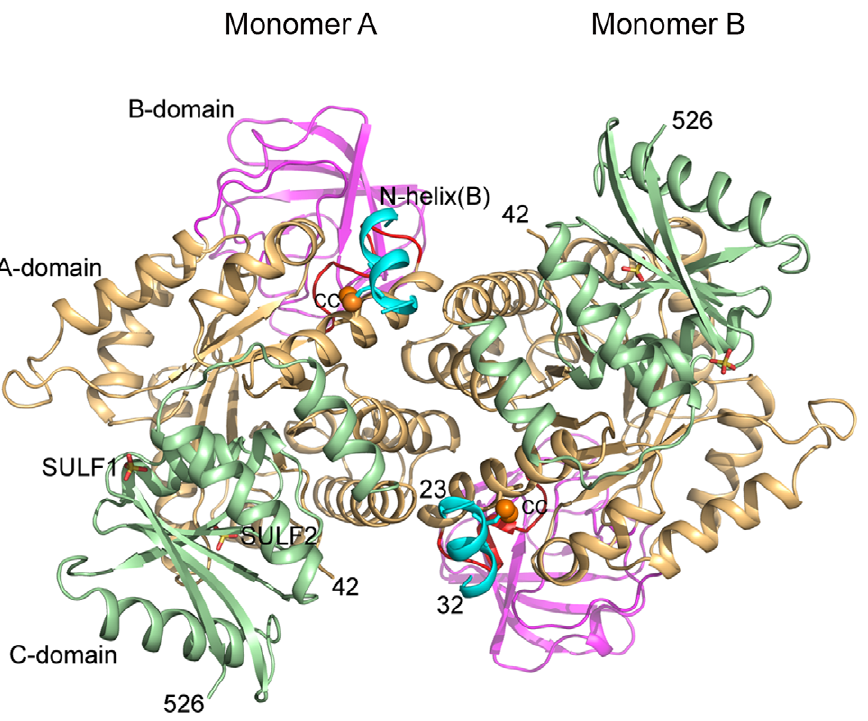
Figure 1. CpPyK asymmetric unit. Monomers A and B comprise the asymmetric unit and are related by a noncrystallographic 2-fold axis perpendicular to the plane of the paper. The domains in each monomer are colored as follows: N - cyan (residues 23–32), A - wheat (residues 42–112 and 212–389), B - magenta (residues 113–211), and C - light green (residues 390–526). The sulfate ions are shown as stick models; the sulfate ion bound at the effector site in each monomer is labeled SULF1. The sulfur atoms of cysteine residues 26 and 312 in each monomer are shown as orange balls; the disulfide is indicated by CC. The unwound helix a 6’ is shown in red in both monomers. The A domains from these monomers form the major protein-protein interface in the tetramer.